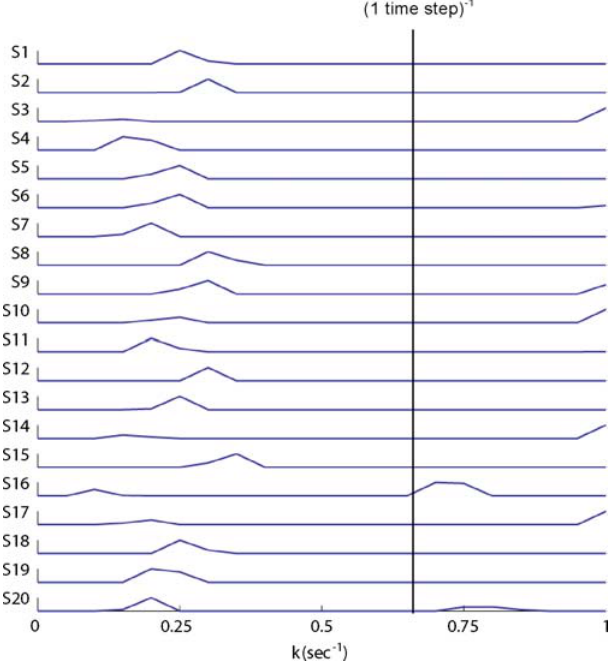
Figure 4. Coefficients of the Exponential Basis Functions Normalized to Unity for Each of the 20 Subjects (S1 to S20) Note the sparseness of the coefficient distribution: all subjects exhibit a single peak for decay rates in the range 0.125 and 0.35 sec (cid:1) 1